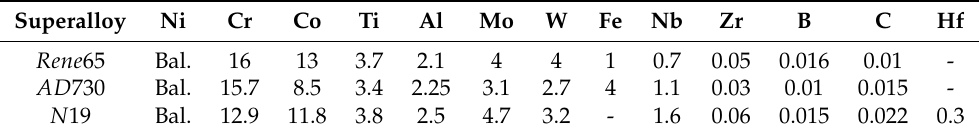
Table 1. Chemical composition of the used billets of René 65 [37], AD 730 [38] and N 19 [39] superalloys (wt.%). Superalloy Ni Cr Co